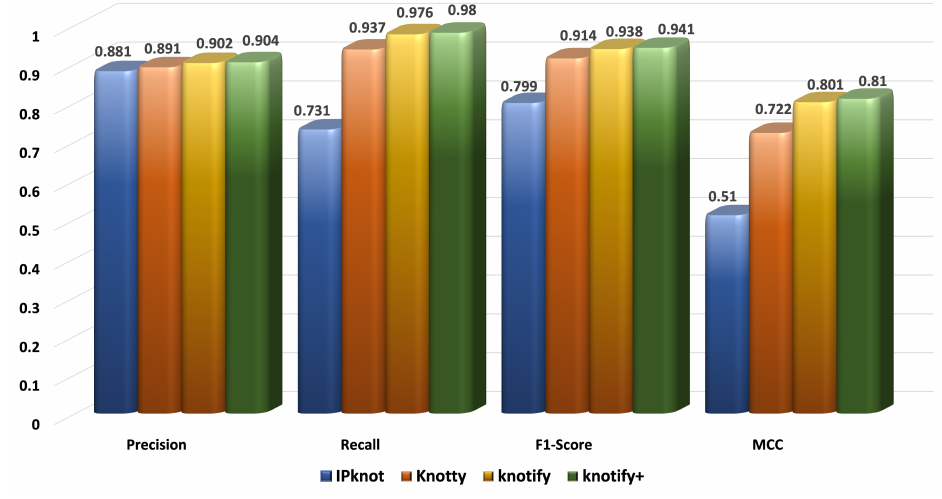
Figure 6. Metrics for the sequences of length < 30.